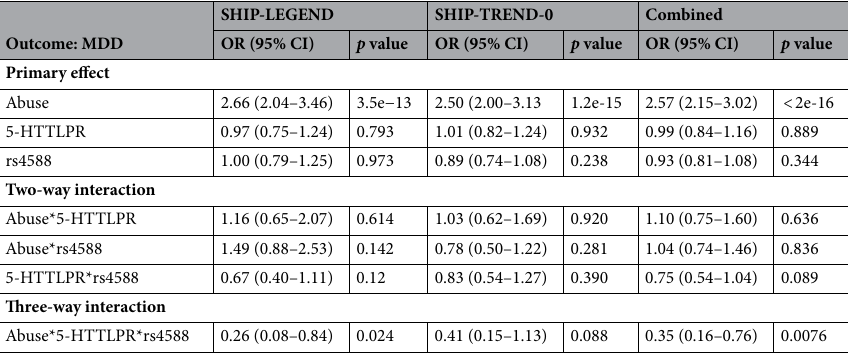
Table 3. Logistic regression of MDD values and different primary effects with robust estimates adjusted for age, sex and study cohort in SHIP-LEGEND, SHIP-TREND-0, and the combined sample (SHIP- LEGEND + SHIP-TREND-0). OR, odds ratio; CI, confidence